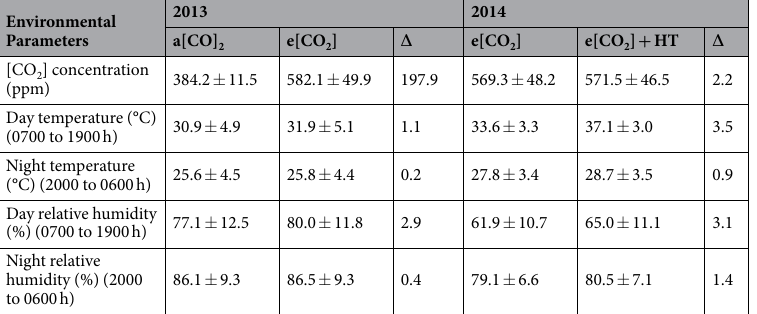
Table 1. Carbon dioxide concentration, temperature and relative humidity (mean ± SD) inside OTCs during 2013 and 2014. Elevated [CO 2 ] was imposed from panicle initiation until maturity (during the day time), while heat treatment was imposed from heading until maturity. ∆ indicates difference in respective parameter within the experiment. a[CO 2 ] – ambient [ CO 2 ], e[CO 2 ] – elevated [ CO 2 ] and e[CO 2 ] + HT– elevated [ CO 2 ] + heat treatment. The data shown for 2014 is from heading to physiological maturity, before this period there were no significant difference in the environmental